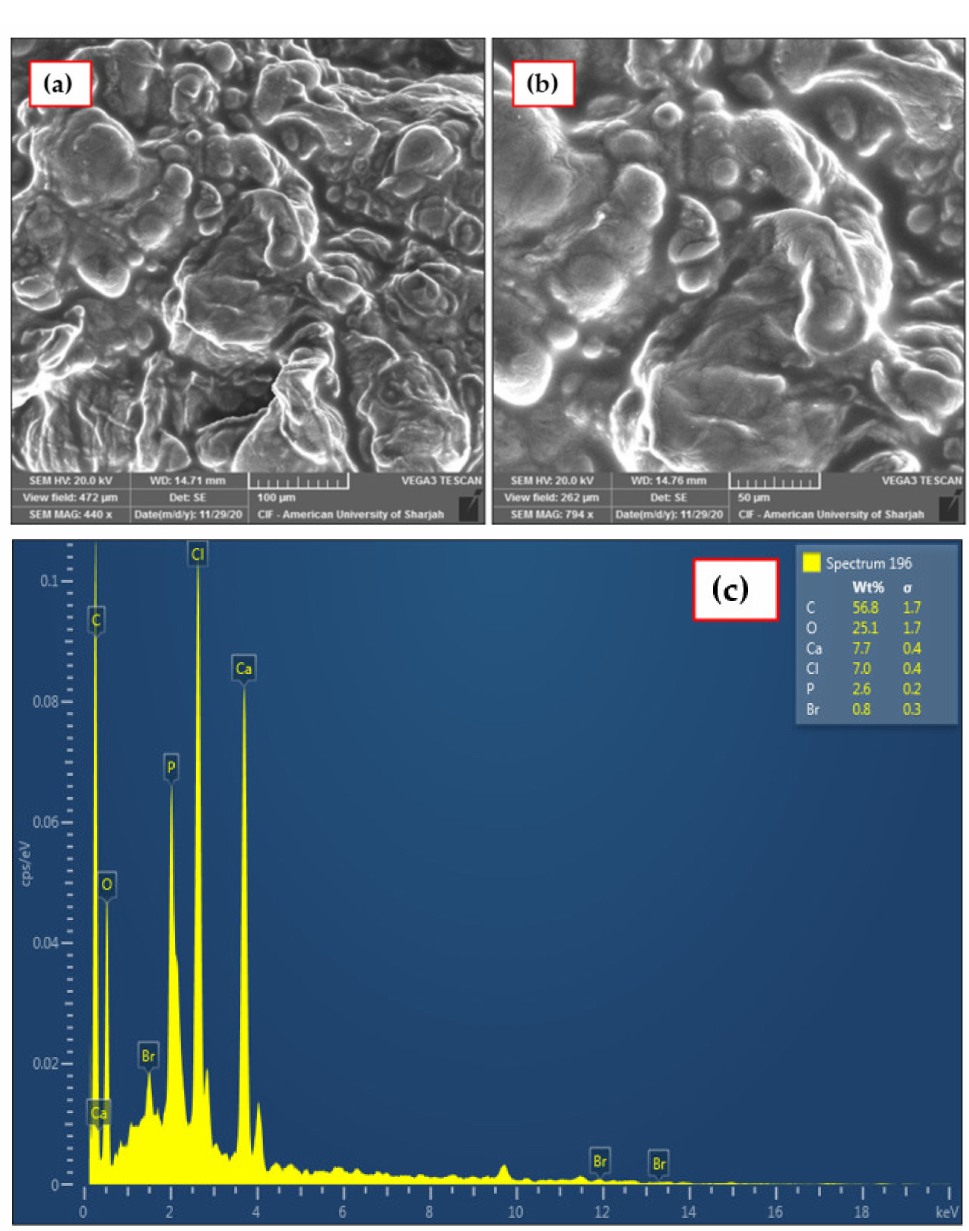
Figure 6. SEM images for adsorbent bead at two different magnifications ( a ) 100 µ m and ( b ) 50 µ m. ( c ) EDX analysis of adsorbent